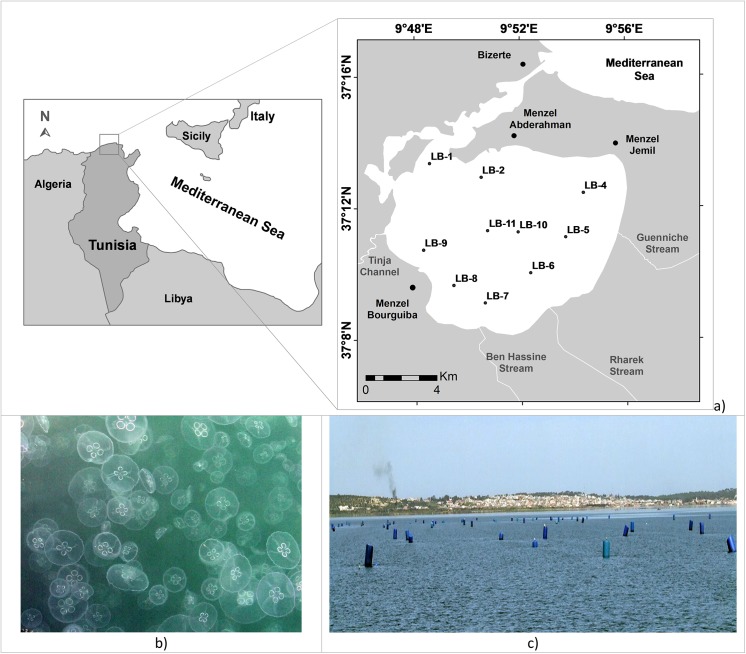
a) Study area in the Bizerte Lagoon (adapted from OTC, 1992, Map of Bizerte Lagoon office de la topographie et de la cartographie de Tunisie). The studied stations are labeled with numbers. The main towns and streams are indicated. b) Photo of the surface water column showing the cnidarian bloom. c) Photo showing suspended structures used in mollusks culture.